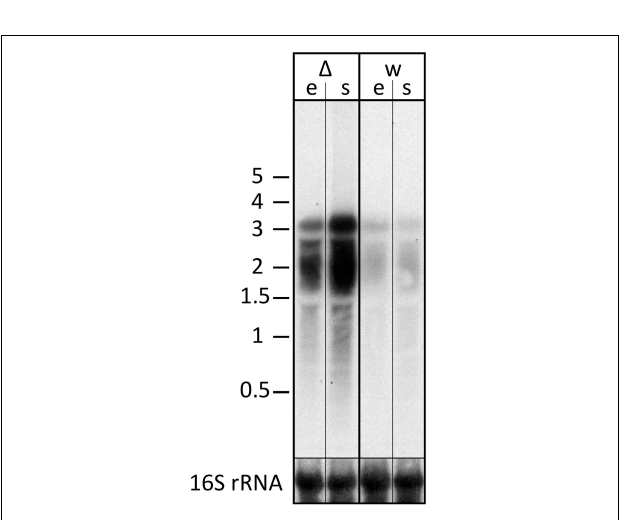
FIGURE 7 | Transcript levels of the znu operon in wild-type and s479 deletion strains. We compared the transcript levels of znu in total RNA of wild-type H66 (lanes w) and (cid:49) s479 (lanes (cid:49) ) cells at exponential and stationary phases (lanes e and s, respectively) using northern blot analysis. The probe used for hybridization in the upper panel is located in the central part of the znuC1 coding sequence ( Figure 5 ). Signals at about 3,000 nucleotides correspond in length to the complete znu operon mRNA, and signals at approximately 2,000 correspond in length to a bicistronic mRNA encompassing either znu A1 and znu C1 or znu C1 and znu B1. In the lower panel, the blot was hybridized with a probe against the 16S rRNA. A size marker is given in kilobytes at the